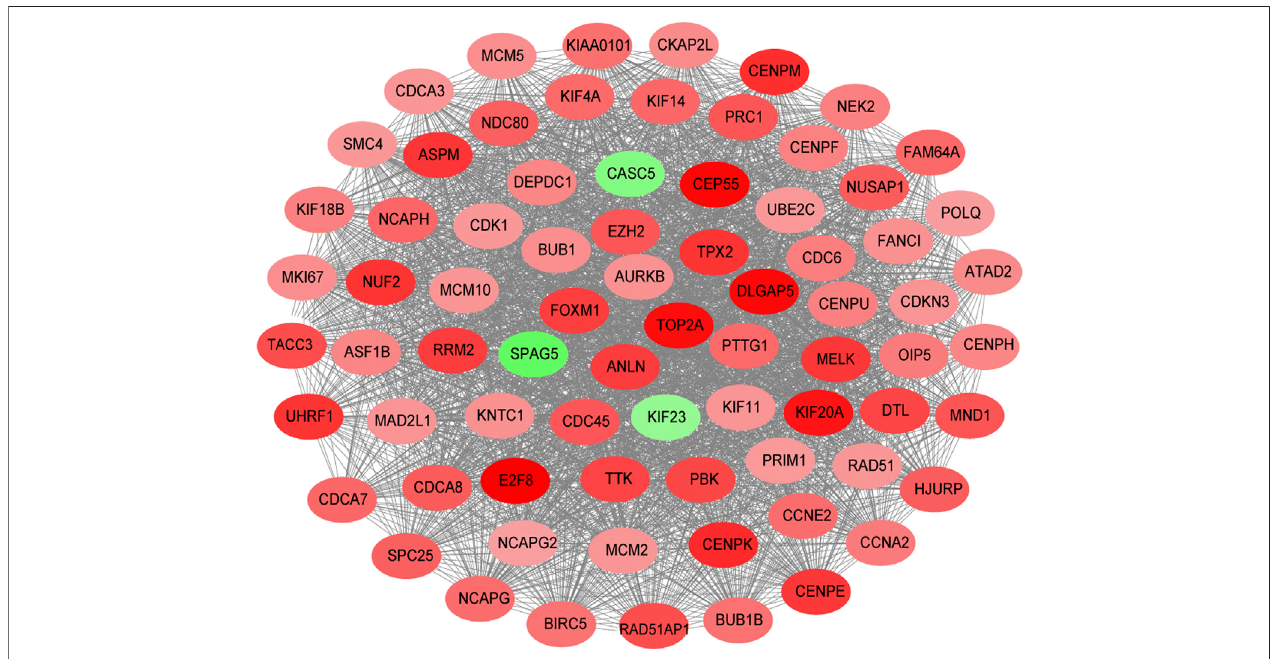
FIGURE 4 | Composition of the molecular